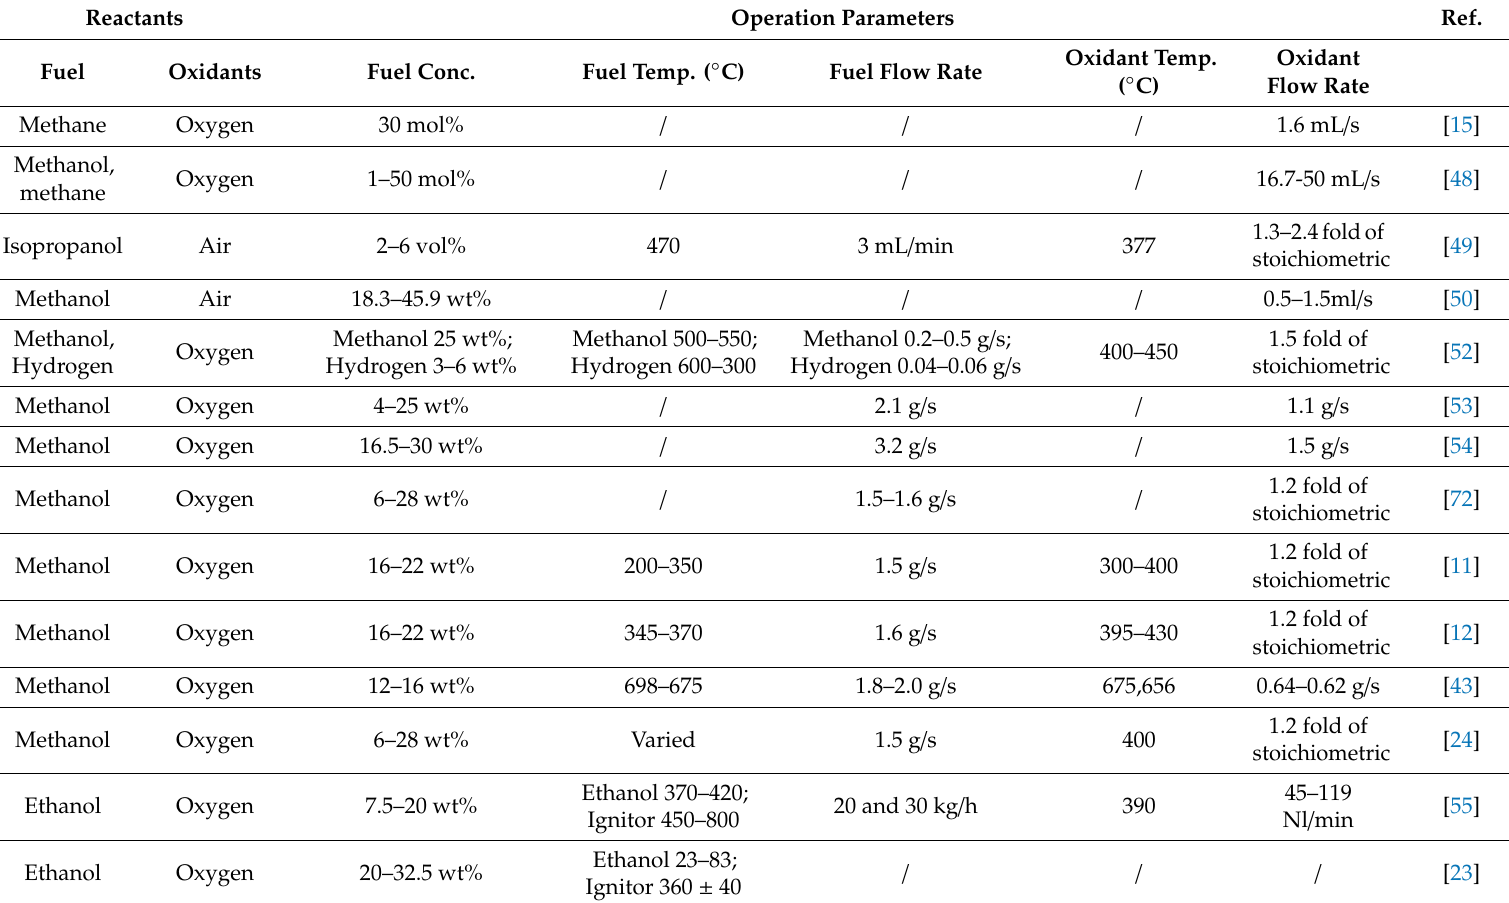
Table 2. Summary of experimental investigations of